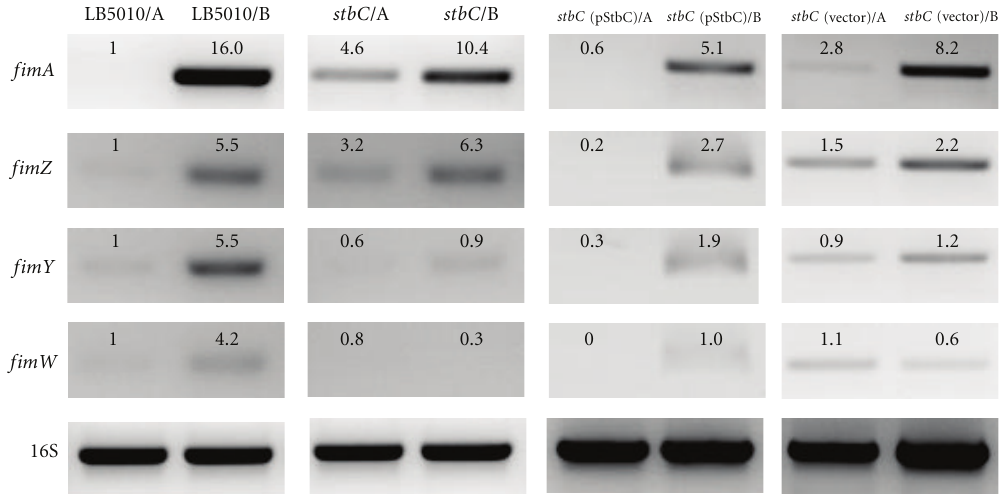
Figure 4: E ff ect of a transposon inserted in stbC on transcription within the fim gene cluster. RT-PCR assays were used to monitor fim gene transcription in Salmonella enterica subsp. enterica serovar Typhimurium LB5010, the stbC mutant, stbC (pStbC), and stbC (vector) cultured on static LB broth and solid LB agar. The intensities of the bands on the gel were determined by densitometry and are expressed relative to the value for Salmonella enterica subsp. enterica serovar Typhimurium LB5010 grown on LB agar.